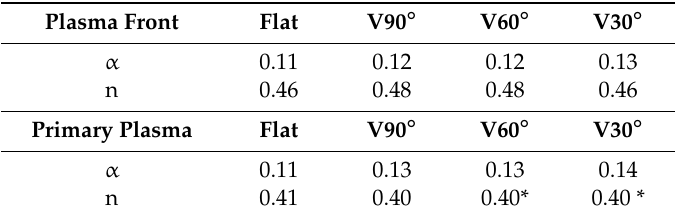
Table 1. Fitting parameters obtained by fits to the point explosion model for the plasma front and the primary plasma. * indicates that the value was forced to this value by the boundaries set in the fitting. Plasma